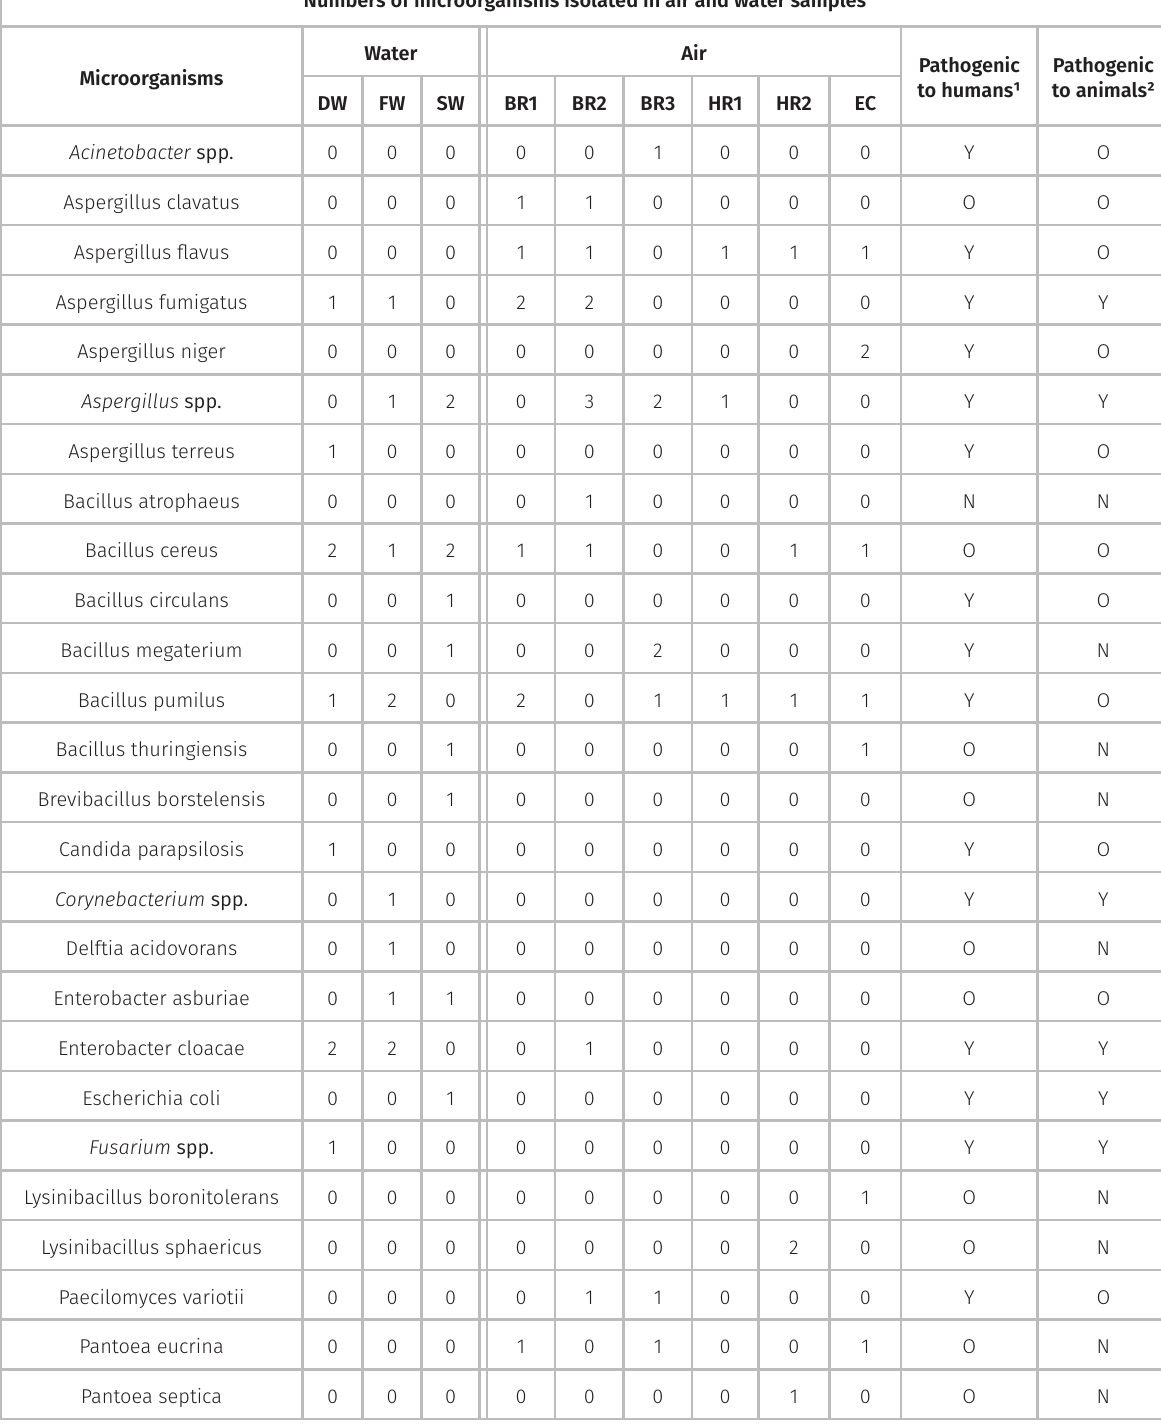
Table III. Microorganisms isolated and identified in the air and water of the rodent facility and their possible pathogenicity for humans and